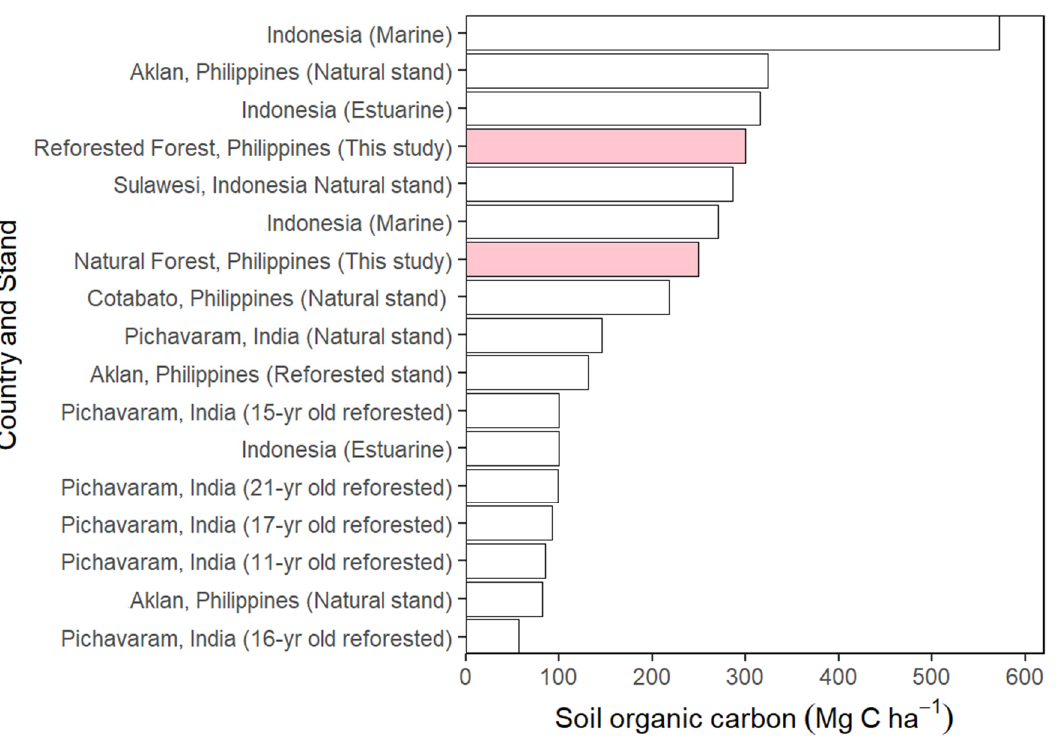
Figure 11. Comparison of studies on mangrove soil organic carbon in the Philippines and other mangrove-rich countries in Asia. These include an estuarine and marine stand in Indonesia [68,69], a reforestation and natural mangrove stands in the Philippines [20,70,71], and reforestation stands in India [72].